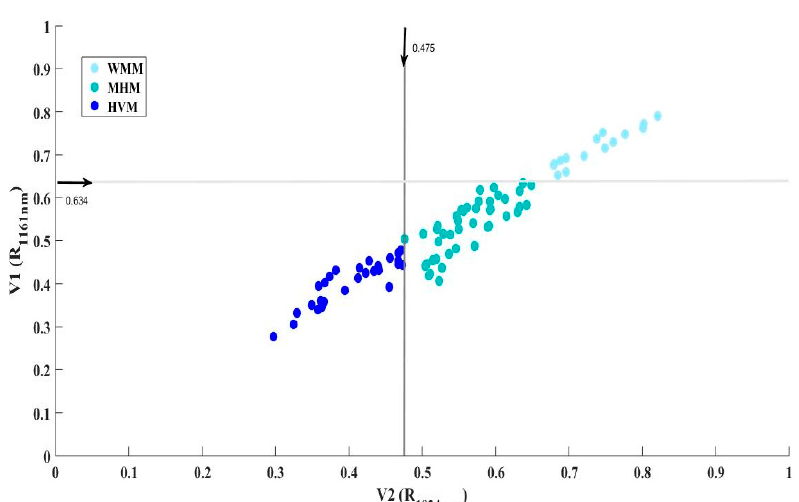
Figure 4. Density class determination using the hybrid model. The light blue, the marine blue, and the dark blue dots indicate the WMM, MHM, and HVM classes, respectively, and represent the calibration database used to calibrate the corresponding estimators. The grey lines are the two discrimination thresholds used based on wavelengths V1 (1161 nm) and V2 (1024 nm).